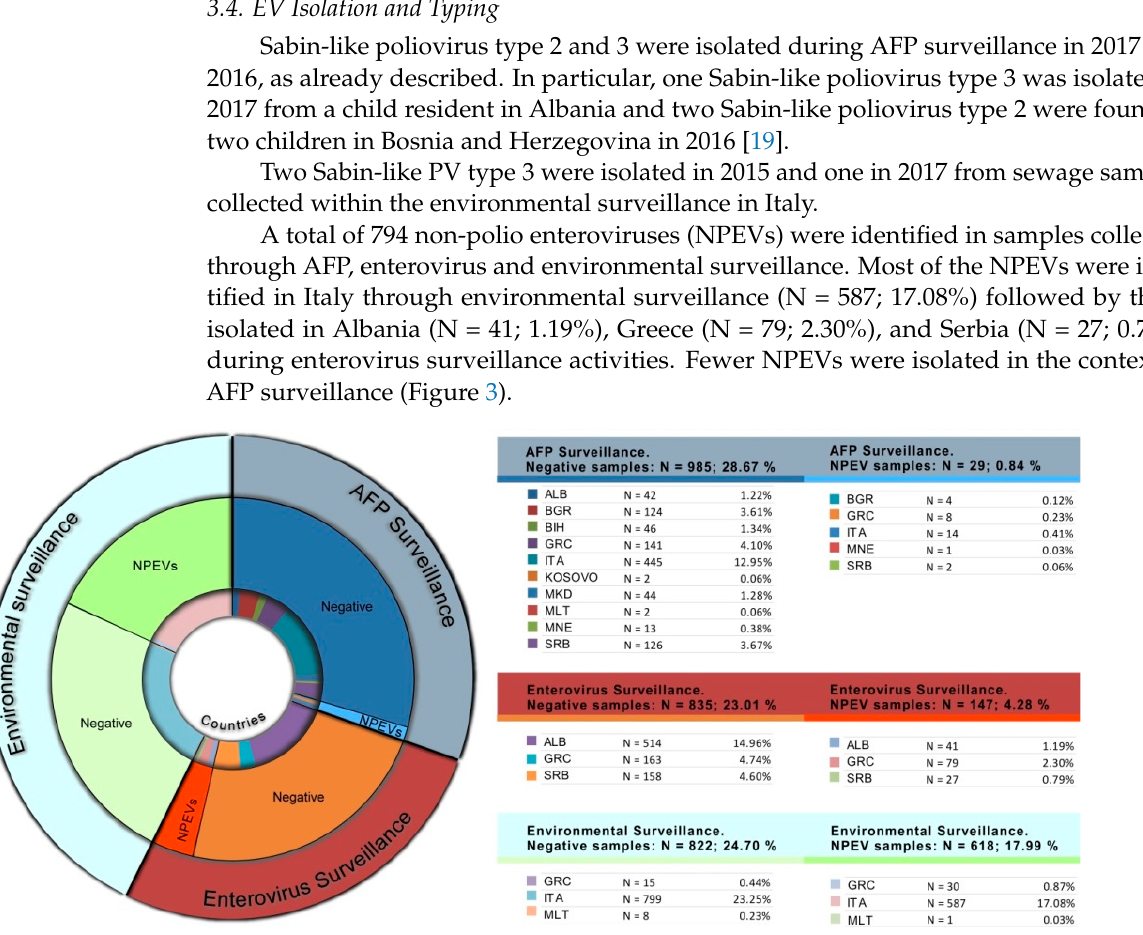
Figure 3. Number and relative percentage of NPEVs identified by type of surveillance and country, 2015–2020.